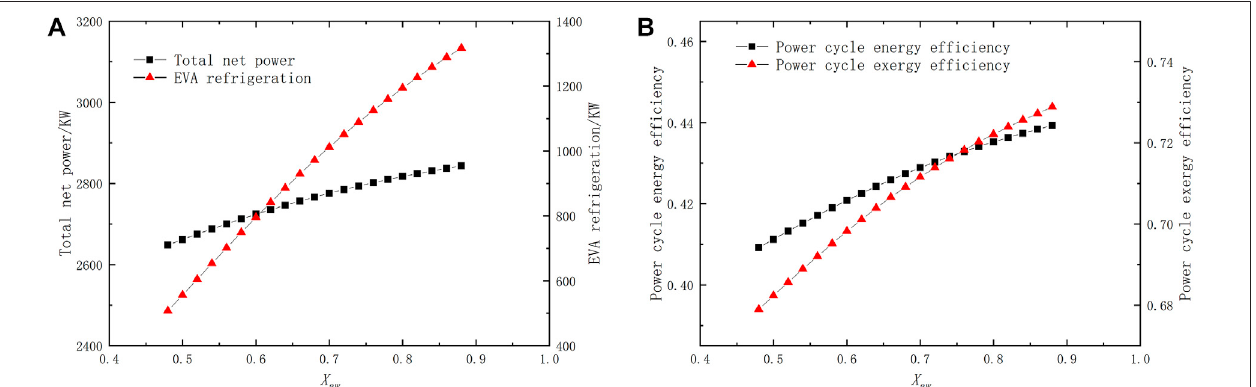
FIGURE 5 | Effect of ammonia concentration of basic solution x